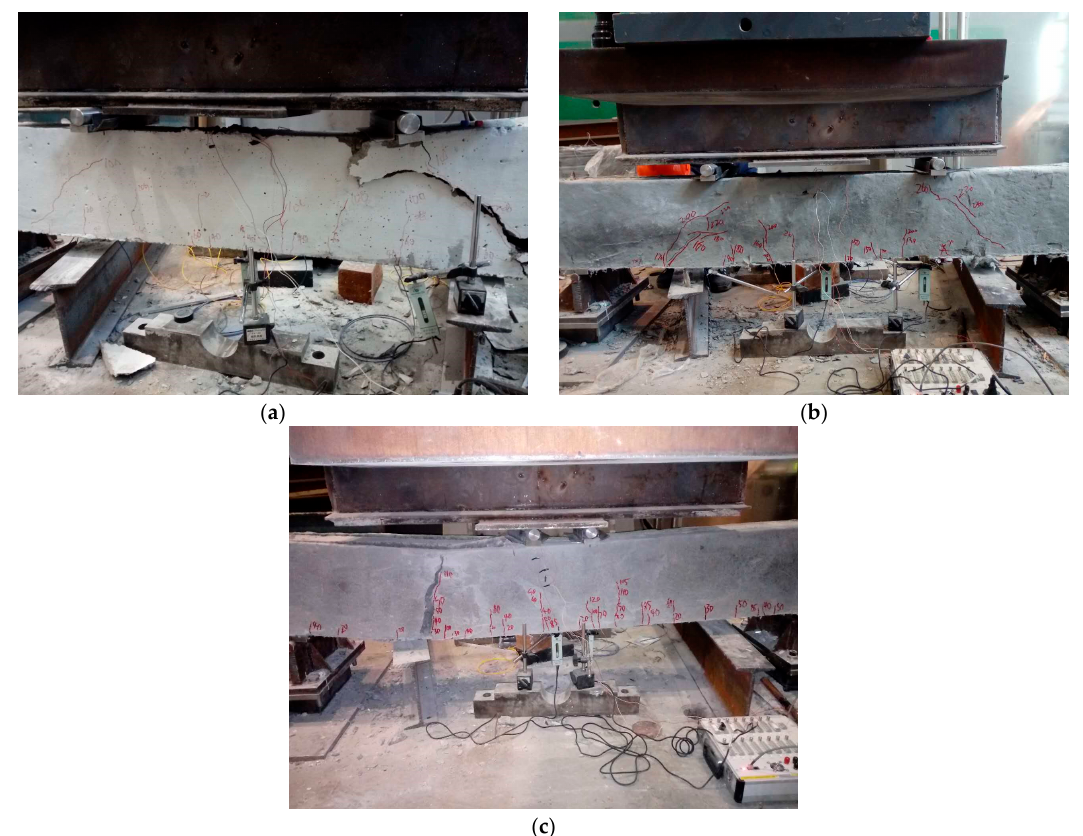
Figure 7. Typical failure modes of the specimens. ( a ) control specimen; ( b ) specimen strengthened with 20 mm ECC layers; ( c ) Specimen strengthened with 40 mm ECC layers.